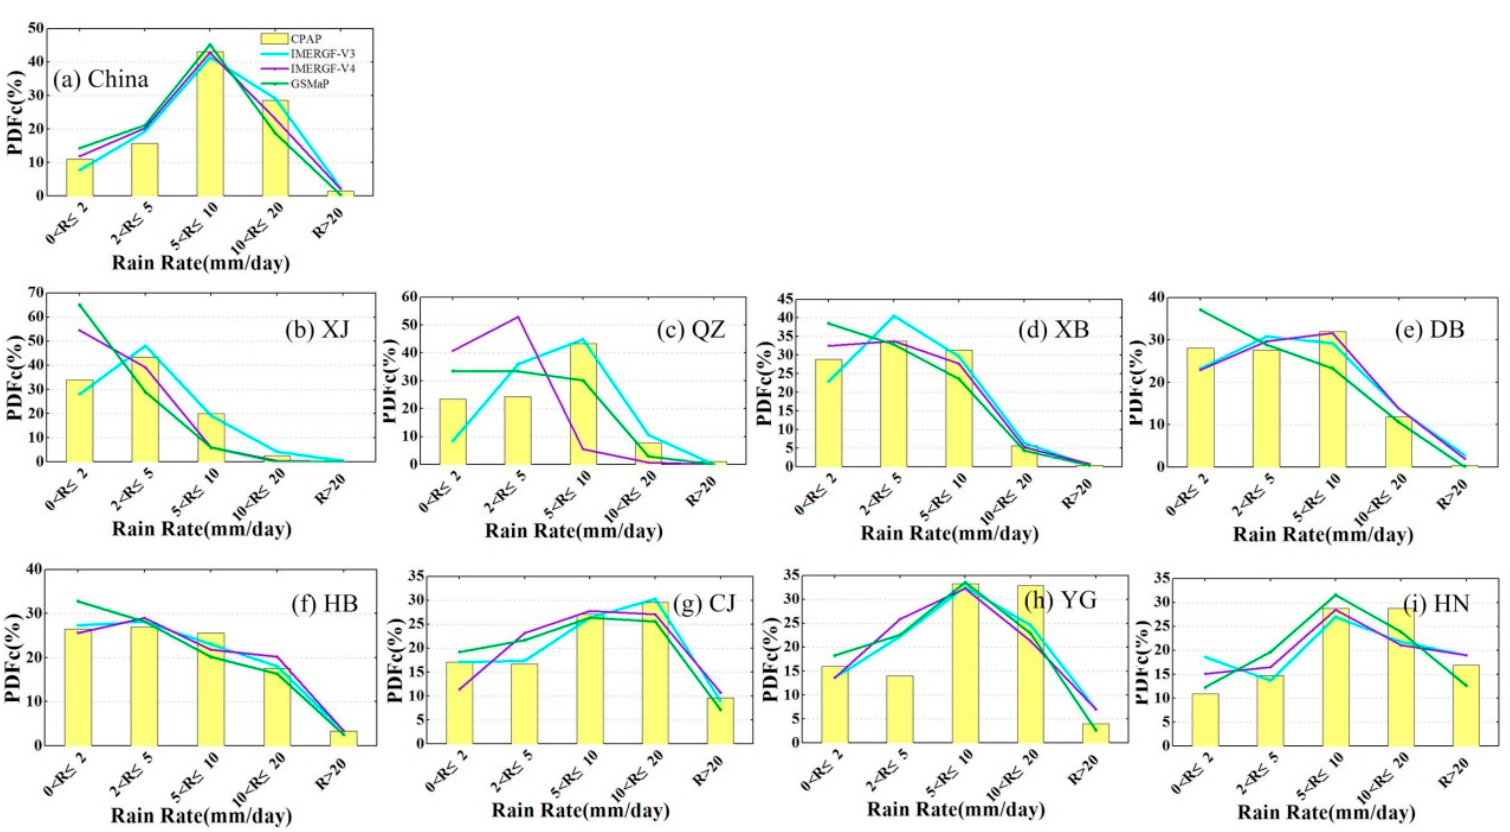
Figure 7. Probability distribution function (PDFc) of daily rainfall for specific rainfall intensity bins over mainland China and eight sub-regions from March 2014 to February 2015. ( a ) represents the PDFc over China and ( b – i ) represents the PDFc distributions over eight sub-regions, respectively.